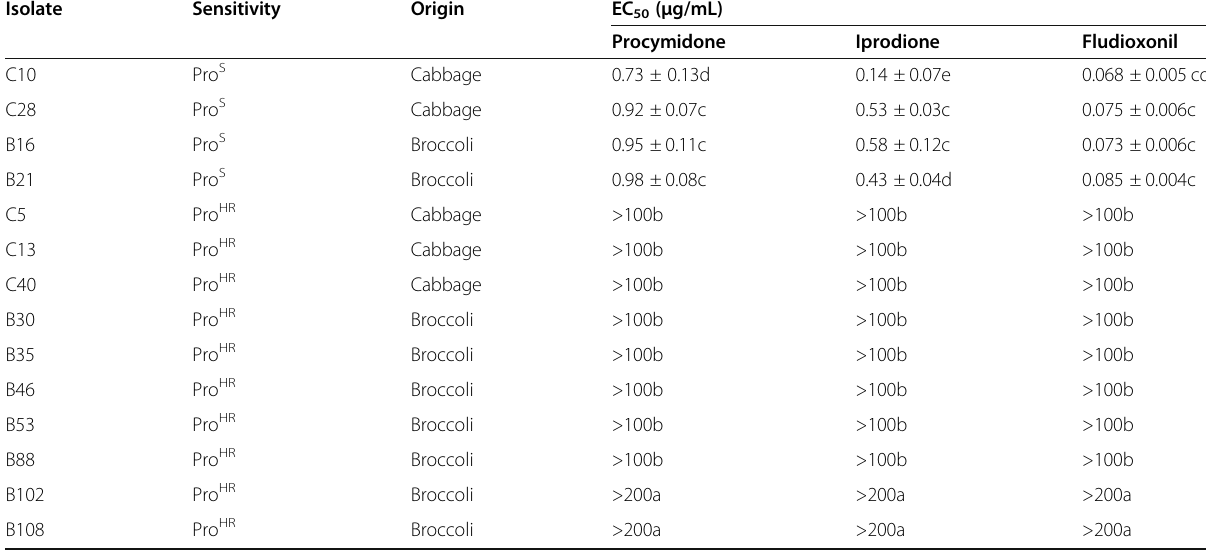
Table 2 EC 50 values of Pro S and Pro HR isolates of Alternaria alternata from broccoli and cabbage